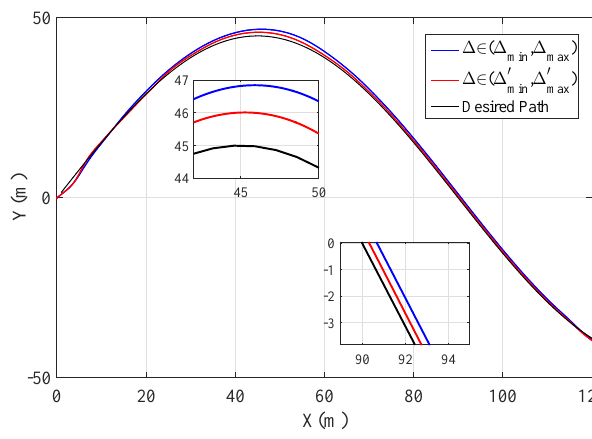
Figure 7. Comparison of different ∆ .